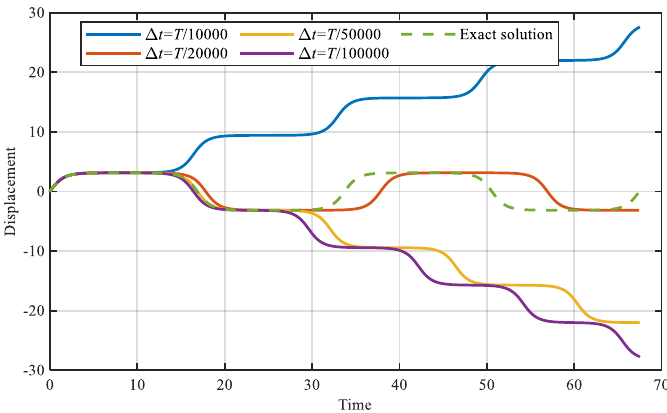
Figure 11. Results of the trapezoidal rule with different time steps Δ t = T /10,000, T /20,000, T /50,000, T /100,000. Table 2. Computational time of different methods for Problem 4.2.